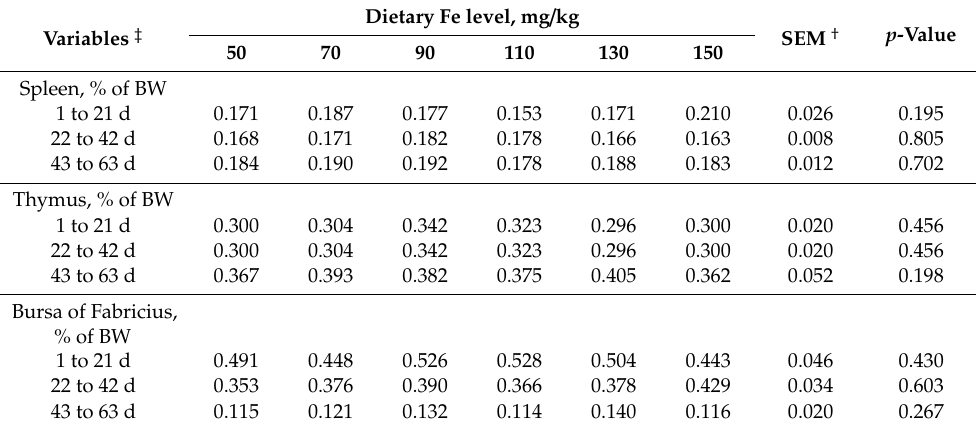
Table 3. E ff ects of dietary Fe on index of immune organ of Chinese yellow broilers during three 21-d experimental